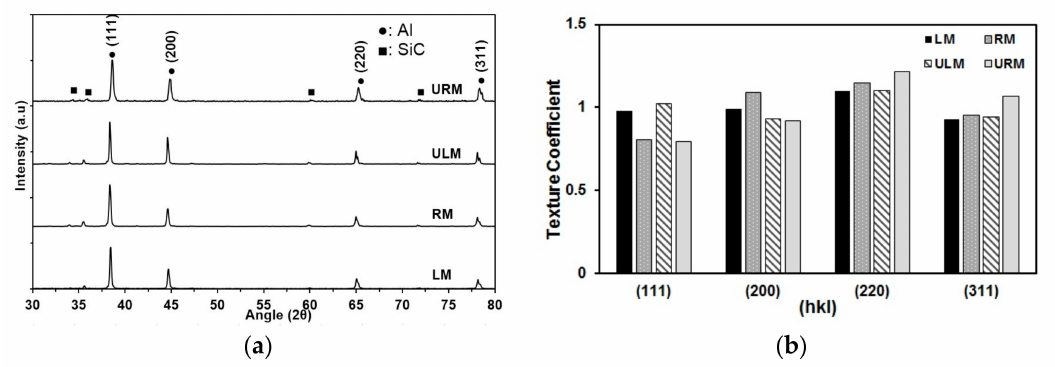
Figure 2. ( a ) X-ray powder diffraction (XRD) patterns and ( b ) texture coefficients for laser clad Al-SiC composite surfaces processed with different laser processing